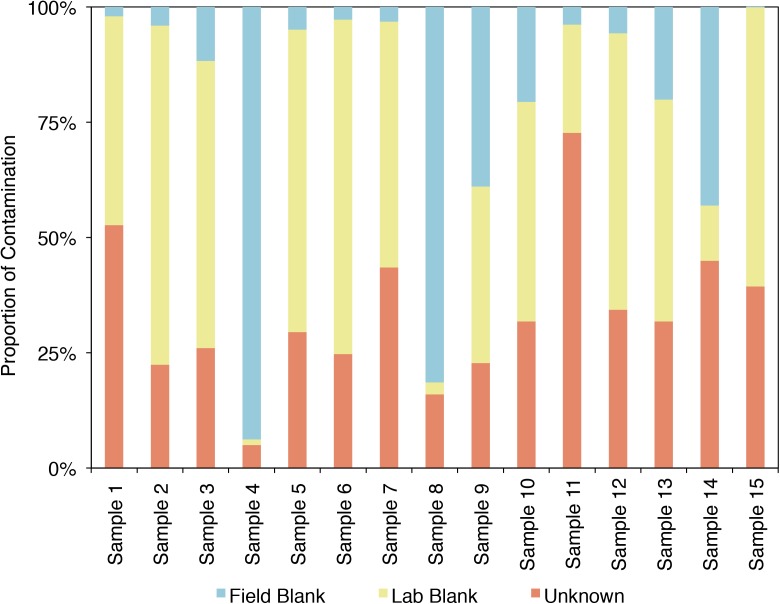
Proportion of the bacterial community of an example CoDL study with previously recognized contamination problems that can be attributed to given sources, as determined by SourceTracker 2 (Knights et al., 2011).